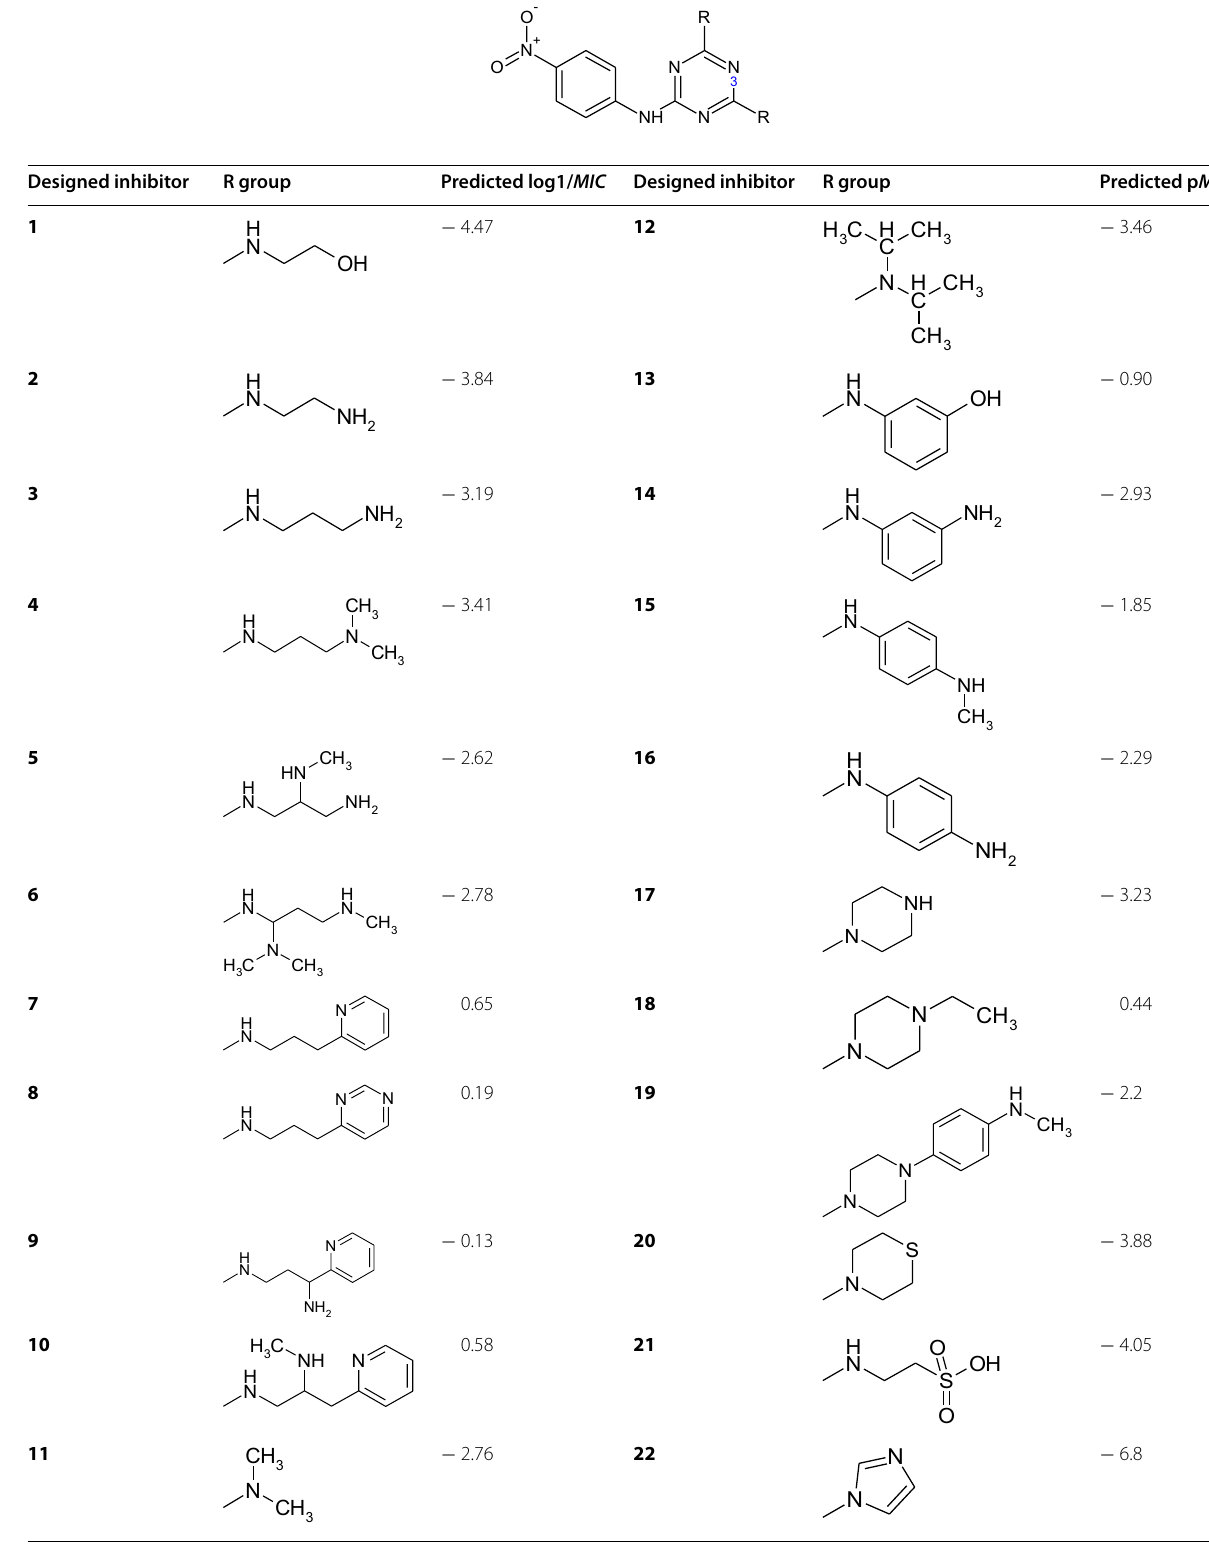
Table 1 Structural features of the designed inhibitors and predicted pMIC values